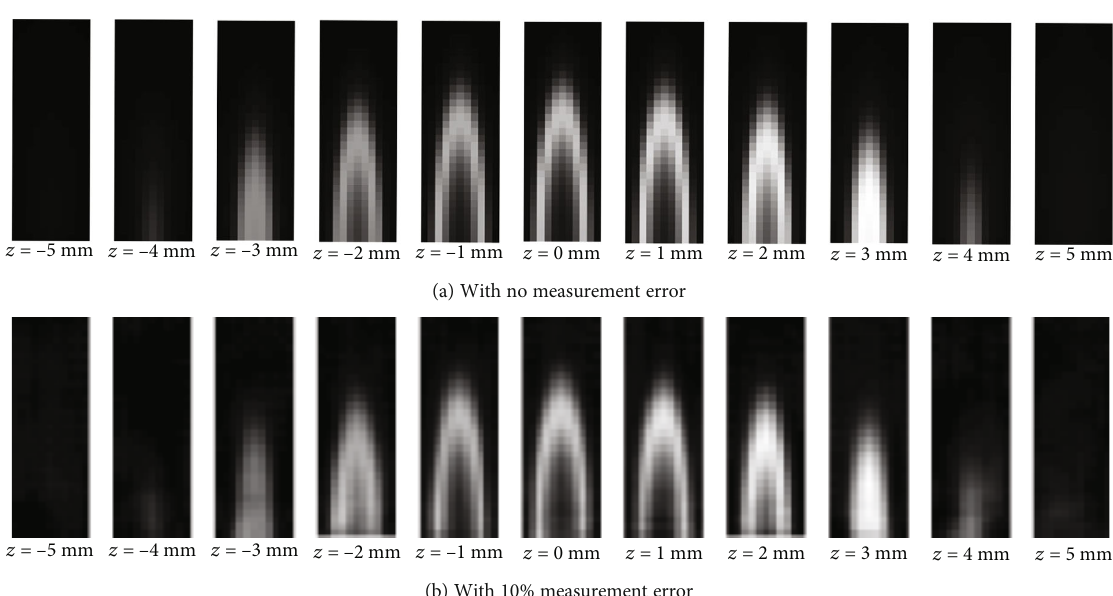
Figure 11: The reconstruction results of transmitted radiative source